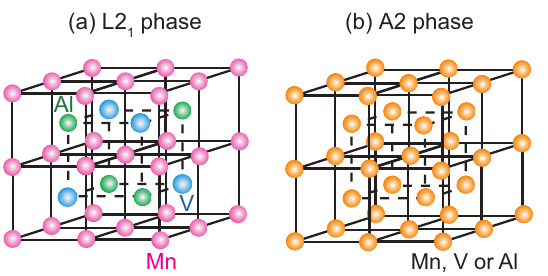
Figure 1. Schematic illustrations of the Heusler-type Mn 2 VAl compound for the ( a ) L2 1 phase and ( b ) disordered A2